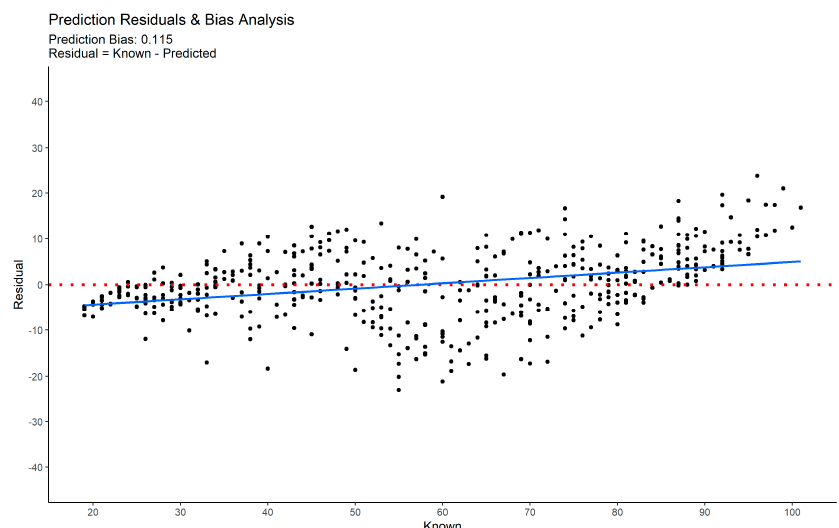
Figure 6. Known vs. predicted age-at-death using a full set of traits (LOOCV, n = 500).